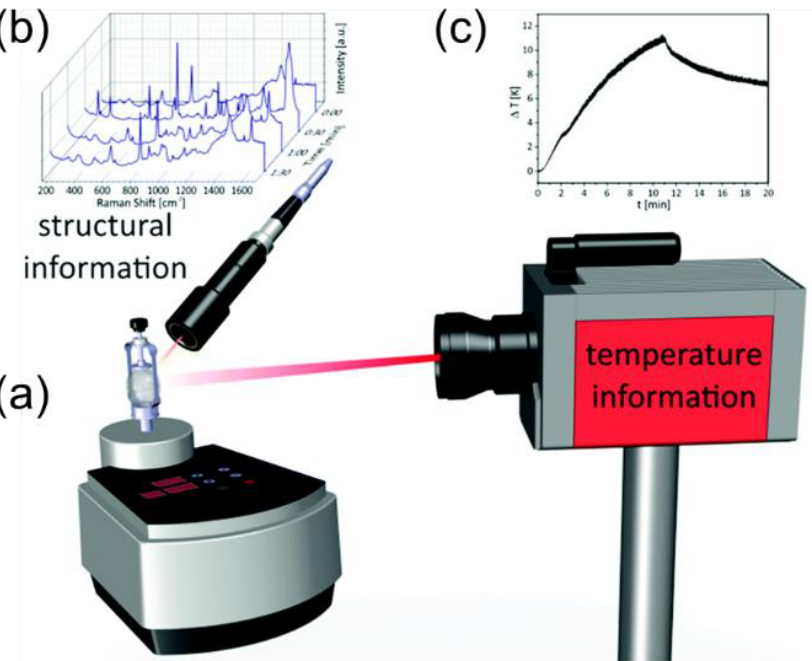
Figure 12. ( a ) Combination of a ball mill equipped with polymer milling vessels with a Raman laser and an IR camera. ( b ) From Raman spectroscopy, structural information is obtained, and at the same time ( c ) temperature changes can be followed over time. Reprinted with permission from [63]. Copyright 2017, Royal Society of Chemistry.